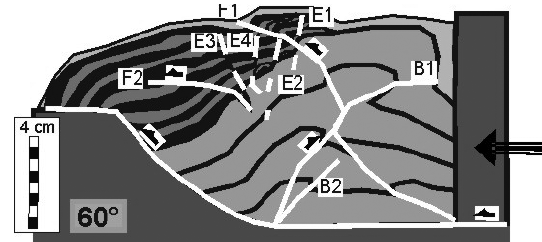
Fig. 12 – Line drawing of a cross-section cut through the central region of model 10: end result. E1-E4 are normal faults formed during ex- tensional steps; F1 and F2 are forethrusts, and B1 and B2, backthrusts. Dashed and continuous lines represent extensional and contractional structures, respectively.